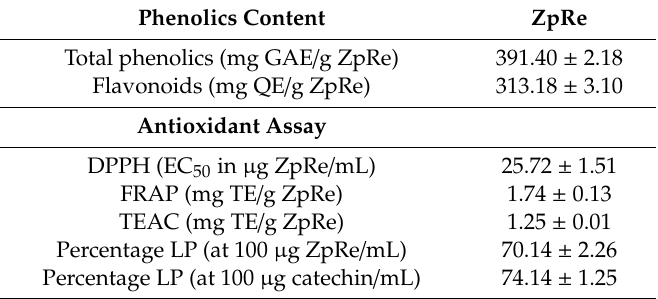
Table 2. Antioxidant assays and total phenolic and flavonoids content of ZpRe from Z. punctata